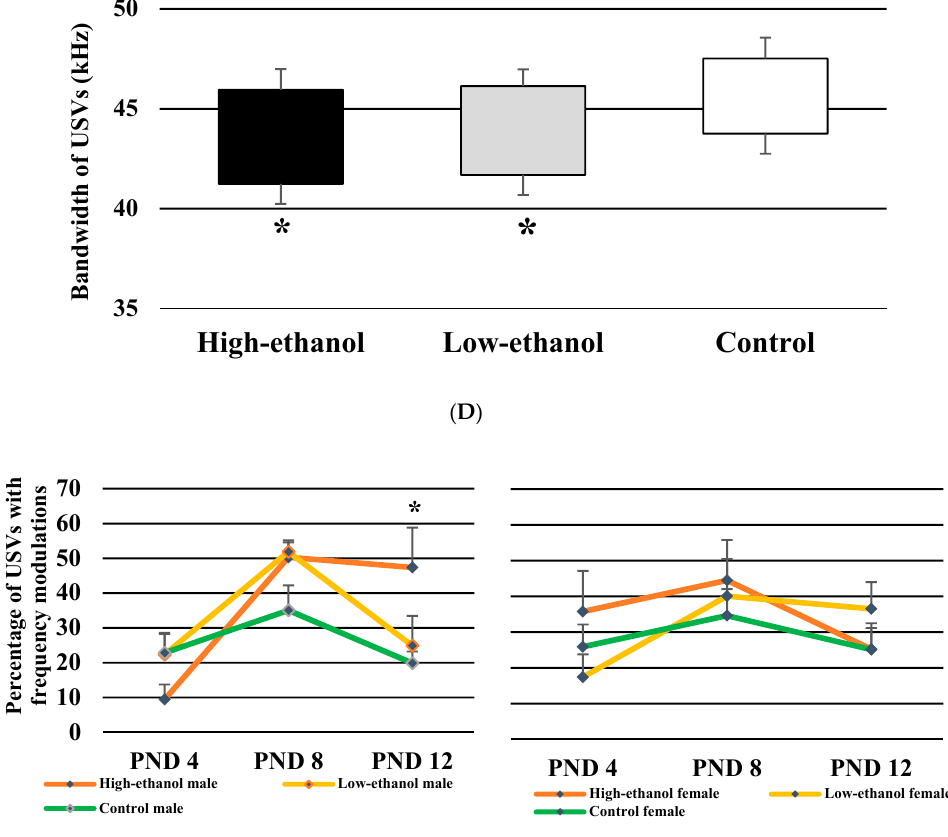
Figure 3. ( A ) Effects of ethanol exposure during lactation on the number of USVs in rat pups; data are expressed as the mean ± SEM; * p < 0.05 compared with that in the control pups; the number of pups was 10 (5 males and 5 females) in each of the three groups. ( B ) Effects of ethanol-exposure during lactation on the mean duration of USVs in rat pups; data are expressed as the mean ± SEM; * p < 0.05 compared with that in the control pups; the number of pups was 10 (5 males and 5 females) in each of the three groups. ( C ) Effects of ethanol-exposure during lactation on the mean fundamental frequency of USVs in rat pups; data are expressed as the mean ± SEM; * p < 0.05 compared with that in the control pups; the number of pups was 10 (5 males and 5 females) in each of the three groups. ( D ) Effects of ethanol-exposure during lactation on the bandwidth of USVs in rat pups; the lower and upper segments of bandwidth indicate the minimum and maximum fundamental frequencies, respectively; data are expressed as the mean ± SEM; * p < 0.05 compared with that in the control pups; the number of pups was 10 (5 males and 5 females) in each of the three groups. ( E ) Effects of ethanol-exposure during lactation on the percentage of USVs with frequency modulations in rat pups; data are the mean ± SEM; * p < 0.05 compared with that in the control male pups; the number of pups was 5 in each of the six groups.